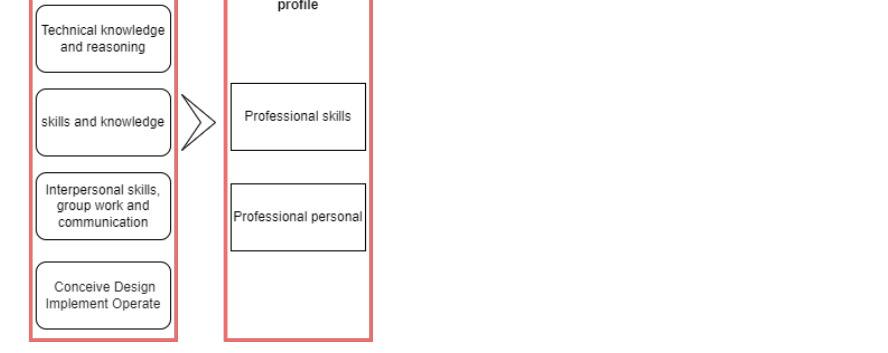
Figure 3. Integration of the expected profile concerning the CDIO syllabus.